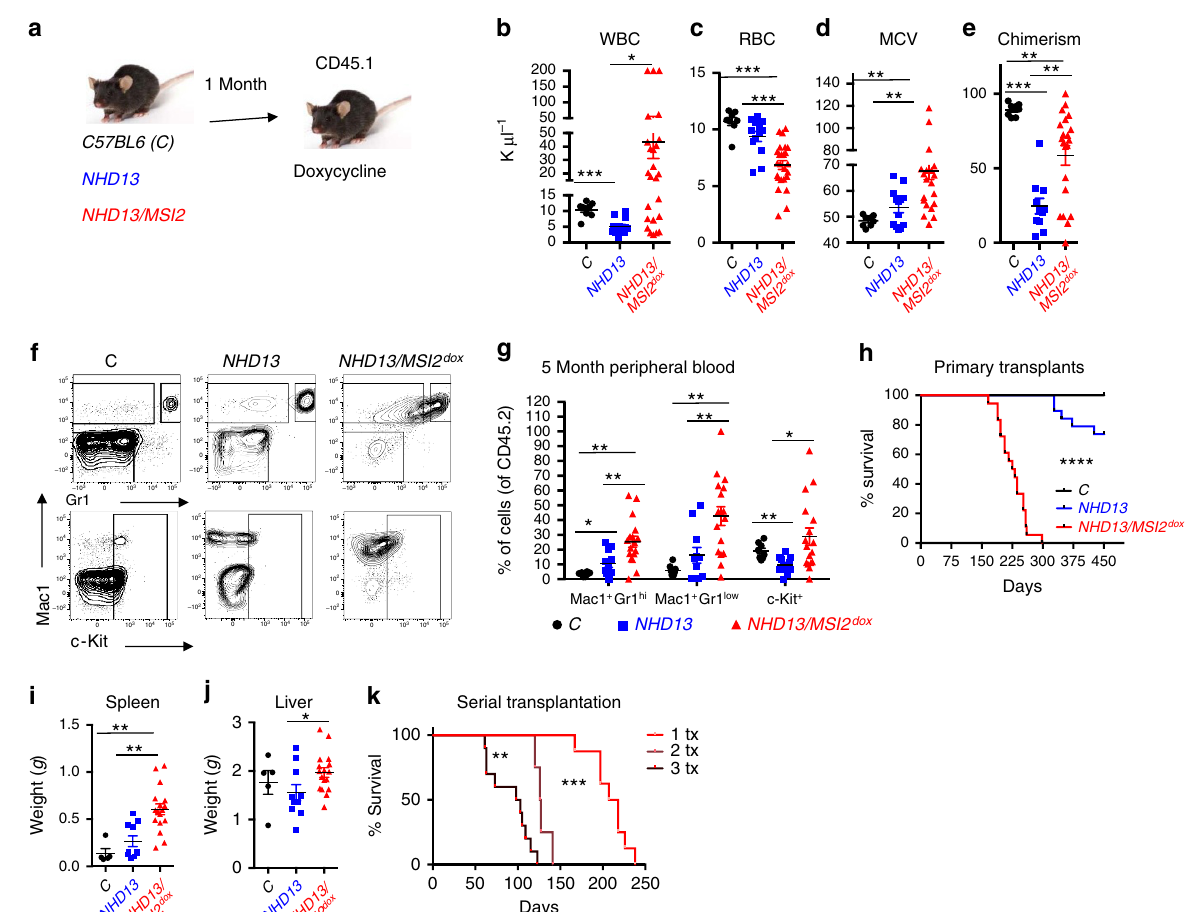
Figure 3 | Sustained MSI2 overexpression transforms MDS to a lethal AML. ( a ) Experimental scheme for MSI2 overexpression in the NHD13 transplant model. ( b ) Peripheral blood analysis 5 months posttransplantation, including WBC. ( c ) Red blood cell count (RBC). ( d ) Mean corpuscular volume